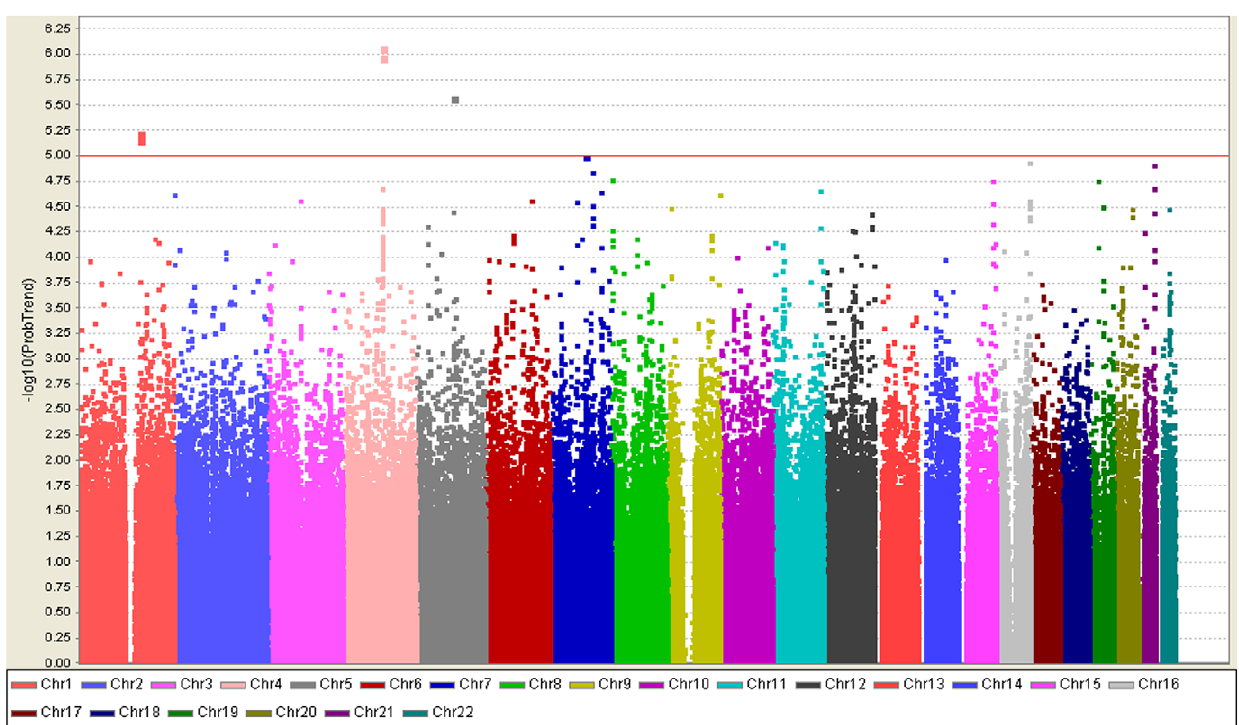
Figure 1. Graphical summary of genome-wide association analysis for TRS in a Han Chinese population. Results ( 2 log 10 P ) are shown in chromosomal order for 694,436 SNPs which were tested in 522 cases and 806 controls by using Affymetrix SNP 6.0 Array. The horizontal line indicates a P -value of 10 2 5 . doi:10.1371/journal.pone.0033598.g001 Table 2. Results of GWAS for TRS in Han population.